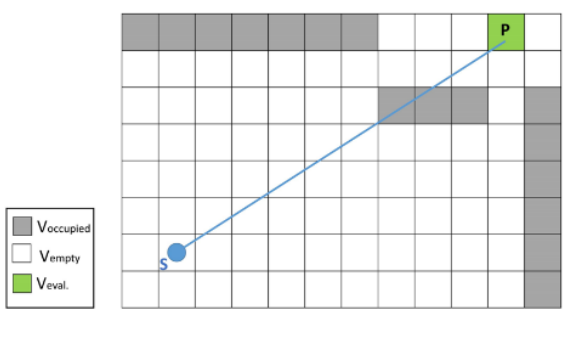
Figure 2. Ray-tracing labelling principle.